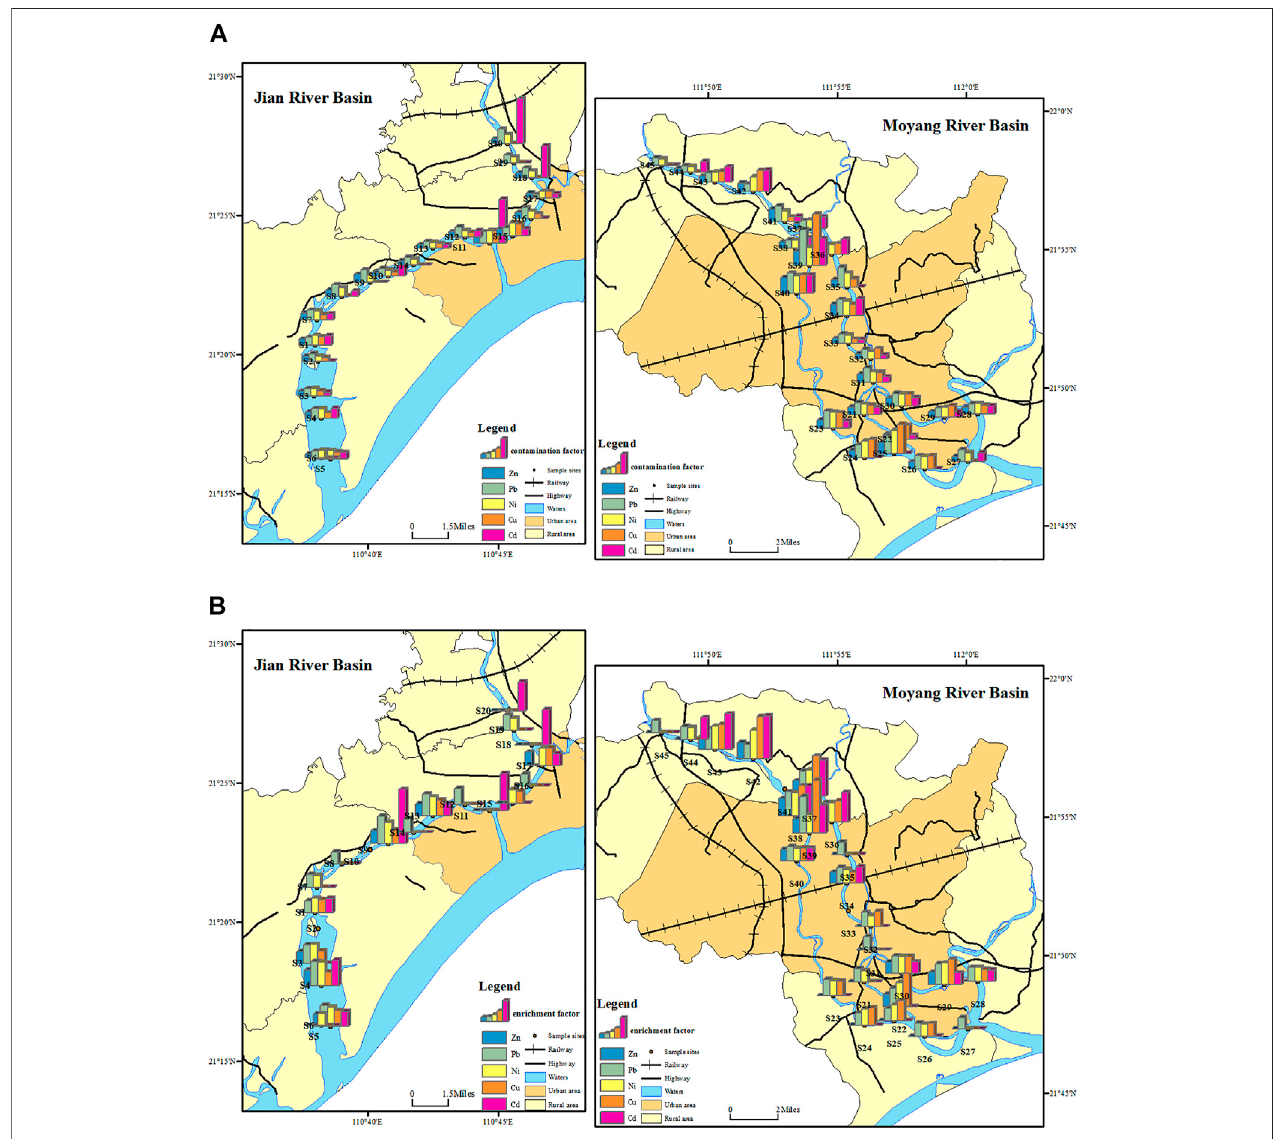
FIGURE 3 | Distribution of pollution evaluation results by CF and EF from Jian and Moyang rivers ’ sediments. (A) Contamination factor; (B) enrichment factor (The resultsofthecontaminationfactoronlyshowthesamplingsiteswithmoderatecontaminationandabove,andtheresultsoftheenrichmentfactoronlyshowthesampling sites with moderate contamination and